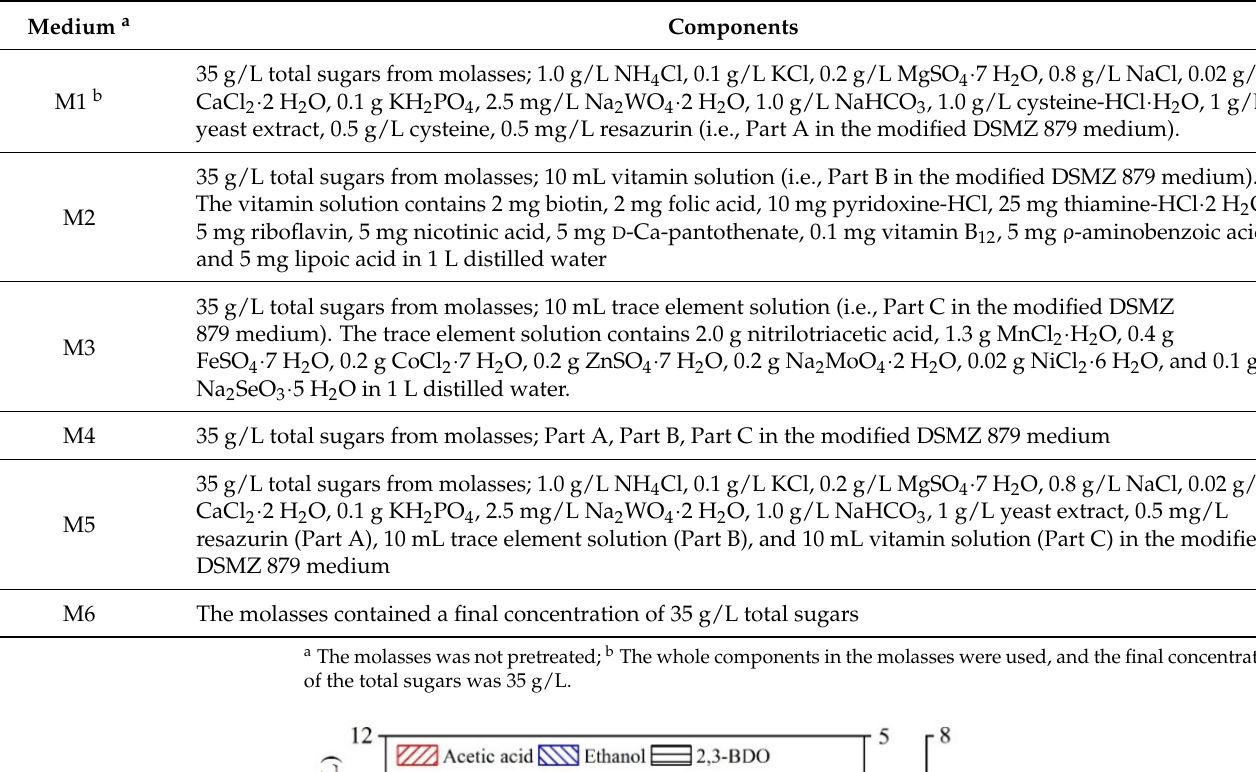
Table 1. The components of M1, M2, M3, M4, M5, and M6.